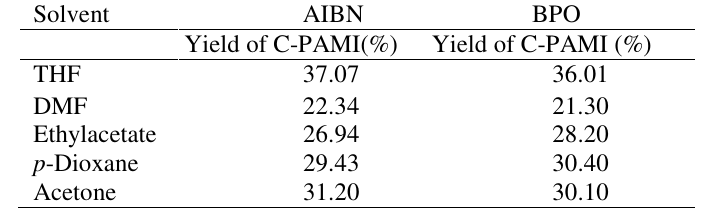
Table 2. Radical copolymerization of N-PAMI and MMA in various solvent-initiators